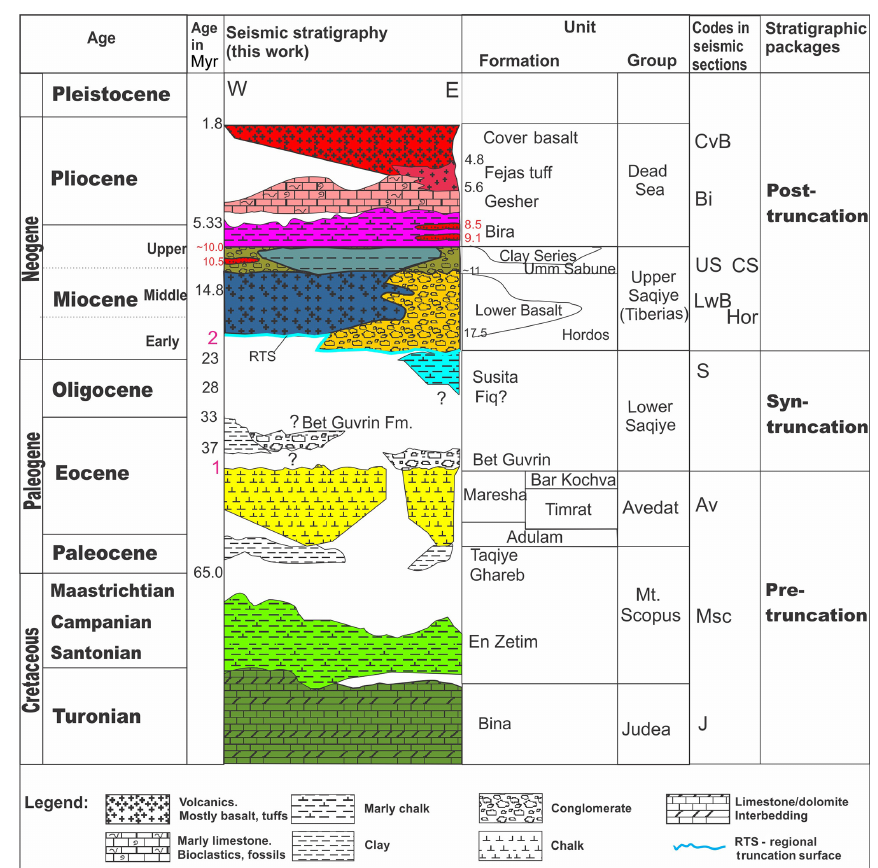
Figure 2. Stratigraphic correlation across the Galilee. Pink numbers (1, 2) represent unconformity surfaces. Radiometric ages (in million years, i.e., Myr) from Shaliv (1991), Heimann et al. (1996), and Segev (2000). Dating of Fejas tuff, Gesher, and Cover Basalt formations (shown in red) from Rozenbaum et al. (2016). Base of Cover Basalt age is from site 3 of Dembo et al. (2015). CvB – Cover Basalt Formation.; Bi – Bira Formation; US – Umm Sabune Formation; CS – Clay Series; S – Susita Formation; Av – Avedat Group; MSc – Mt. Scopus Group; J – Judea